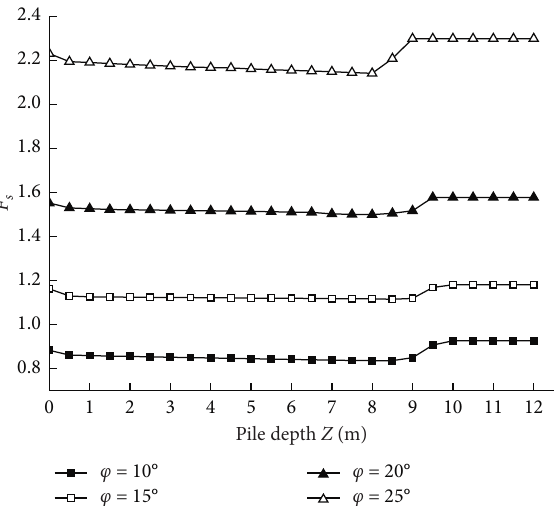
Figure 7: Effects of the friction angle of soil on the stability of 3D slopes.